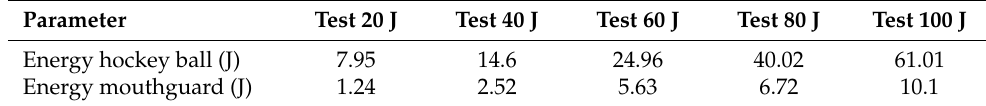
Table 6. Overview of the energy at the end of the impact for hockey ball and